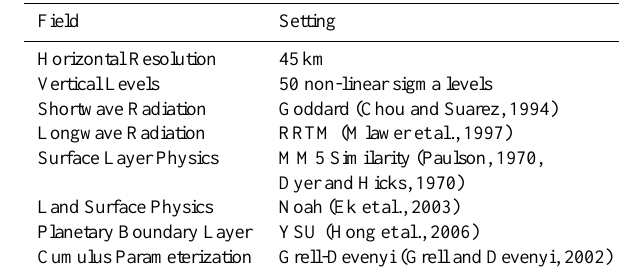
Table 1. WRF-Chem domain and parameterization settings used in this study. Details about WRF-Chem can be found in Grell et al.